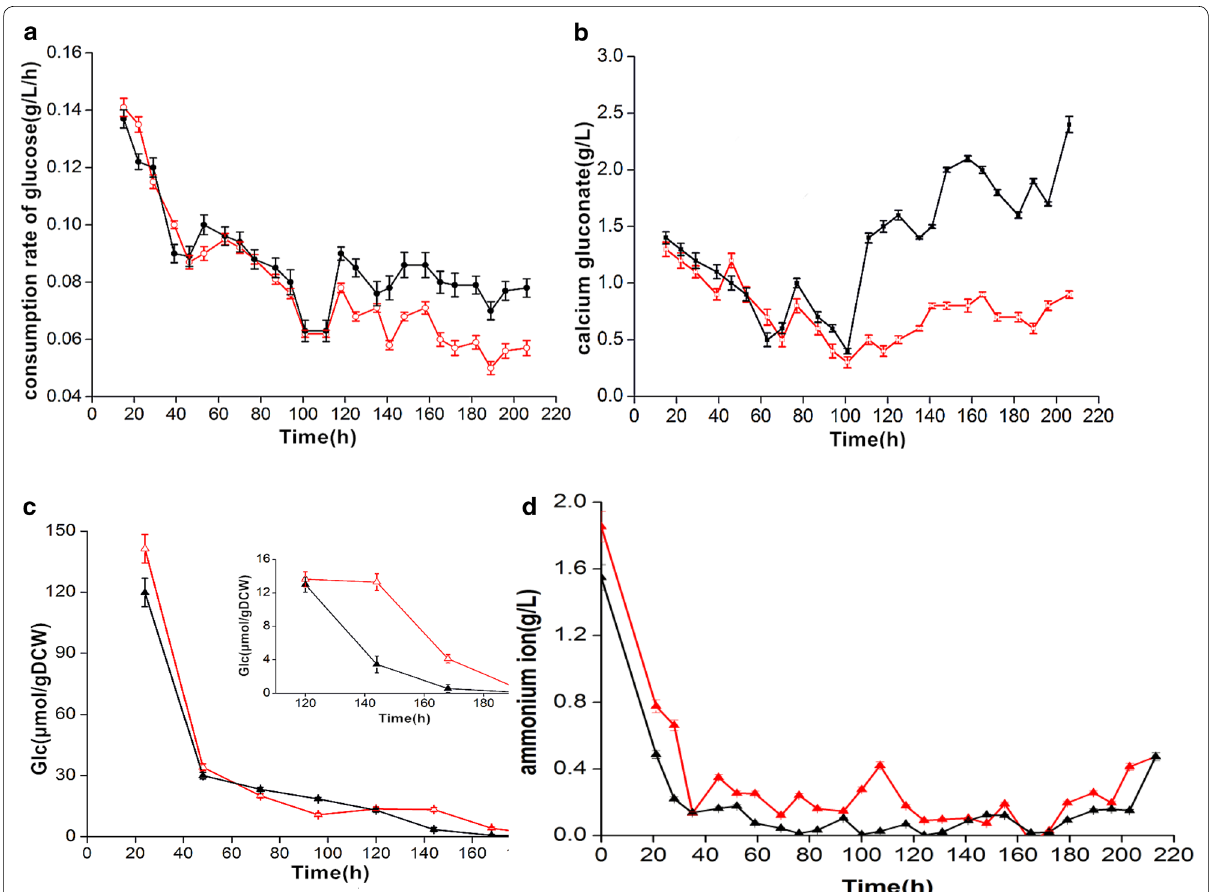
Fig. 3 Time course changes of glucose (Glc) consumption rate ( a ), calcium gluconate concentration ( b ), intracellular Glc concentration ( c ), and extracellular ammonium ion concentration ( d ). Black: mode 8. Red: control. Each point represents the mean ( n